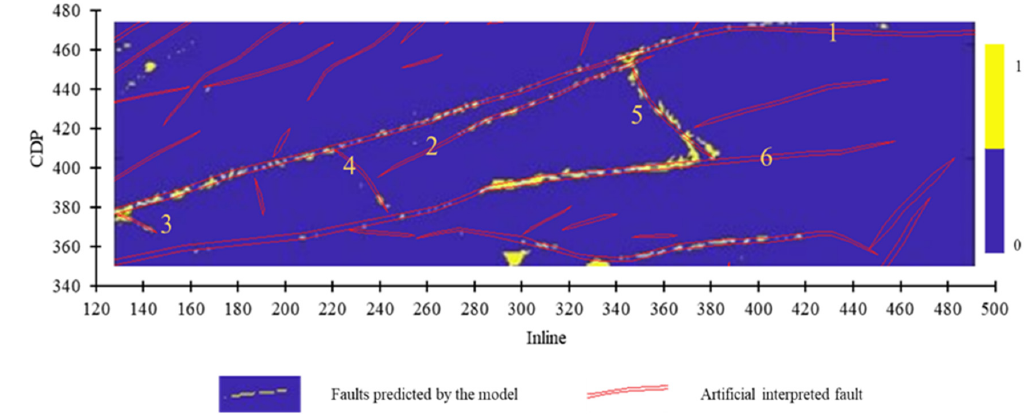
Figure 18. The prediction result of Faults 1–6 by Region C as training set.